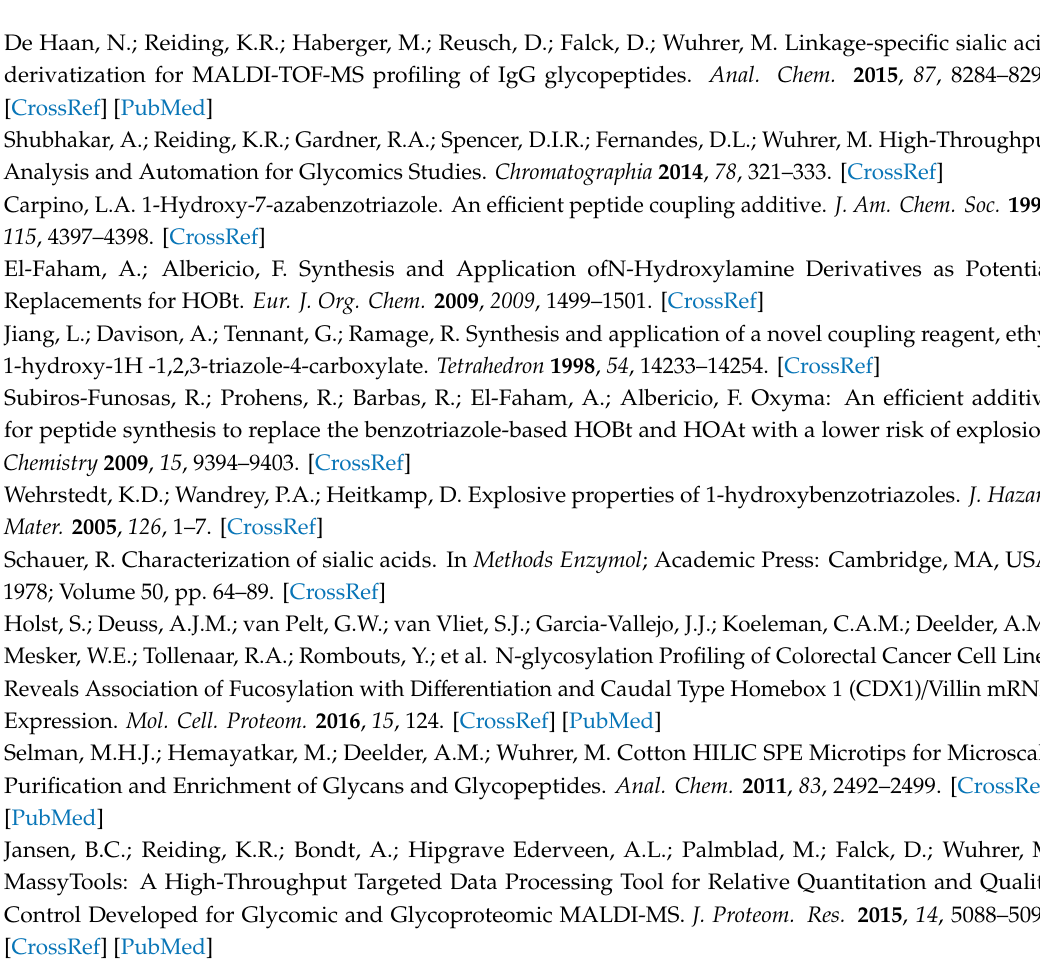
are commercially available (Table